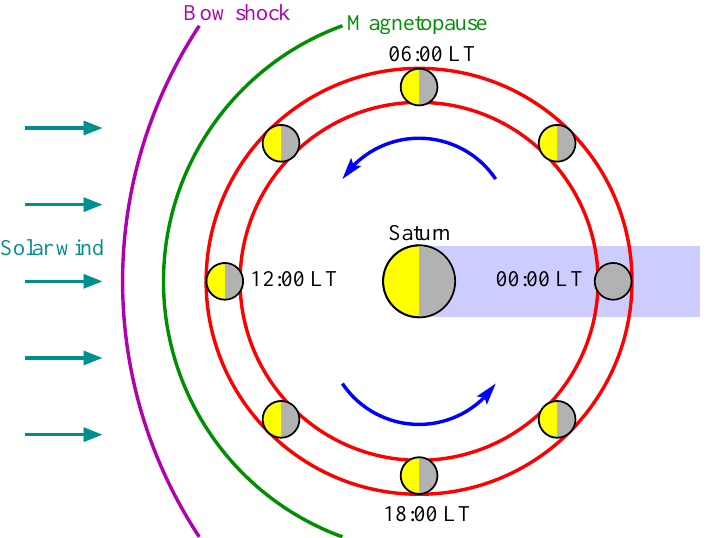
Fig. 1. Titan’s orbit around Saturn. The abbreviation “LT” in the sketch denotes the Saturnian local time. Titan orbits Saturn at a distance of 20.3Saturn radii with an orbital period of 15.95days. Since this period is significantly longer than Saturn’s rotational period, Titan’s atmosphere is permanently exposed to a flow of corotating magnetospheric plasma. The blue arrows denote Titan’s rotational direction as well as the direction of the corotating plasma flow. The plasma flow velocity with respect to Titan is of the order of 120km / s. As can be seen from the figure, the Titan situation features the possibility of having the dayside ionosphere located on a face not aligned with the ram flow of the Saturnian magnetospheric plasma, leading to a variety of different interaction scenarios. Titan’s orbit is located inside Saturn’s magnetosphere for average solar wind conditions when the stand-off distance of the bow shock is of the order of 24Saturn radii. However, when Saturn’s magnetosphere is compressed due to high solar wind dynamic pressure, Titan might leave the magnetosphere in the subsolar region of its orbital period. Under these circumstances, the ionosphere can interact directly with the supersonic solar wind. Such a compression of Saturn’s magnetosphere was detected during the Pioneer 11 flyby (Schardt et al.,